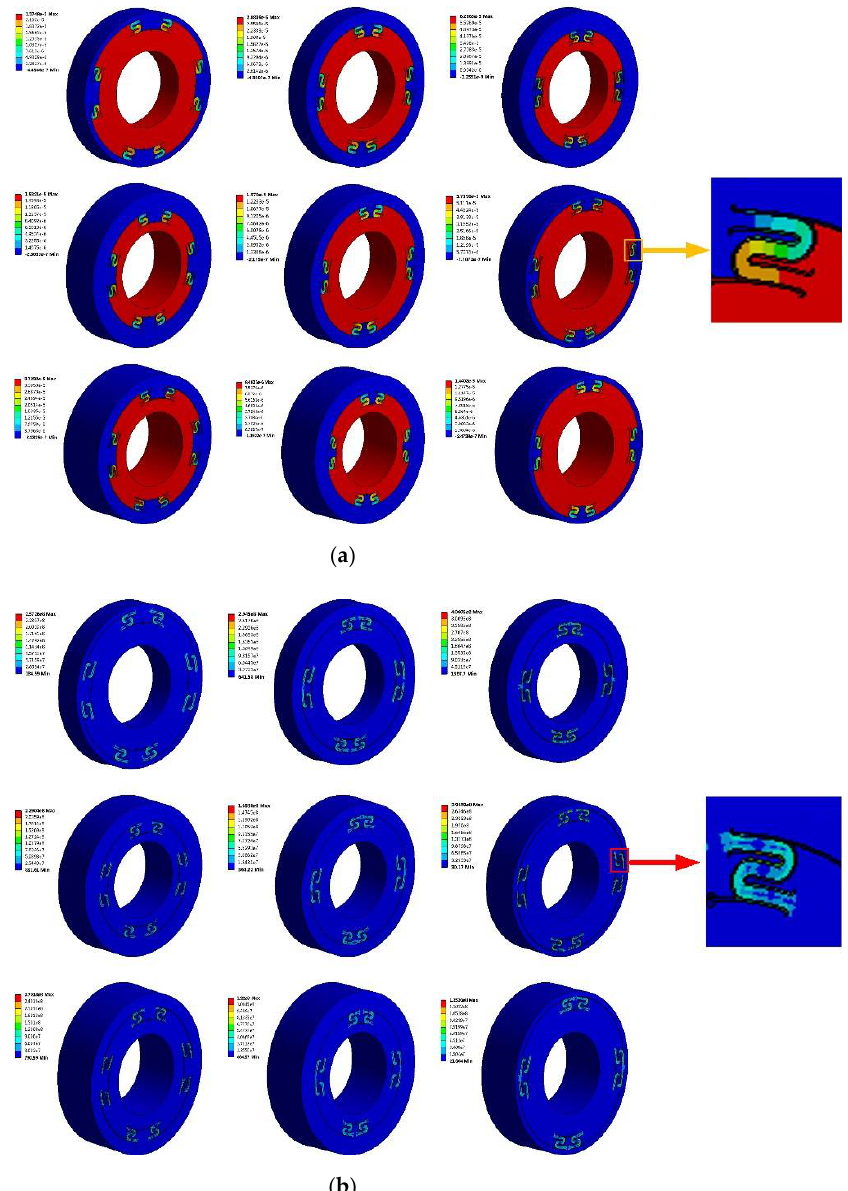
Figure 7. Simulation results of Run No. 1–9 of stiffness and stress: ( a ) Stiffness plot; ( b ) Stress plot. A four-factor, three-level orthogonal test table L 9 (3 4 ) is used to conduct three replicate experiments to increase sample diversity and reduce the effect of error. A total of 27 sets of data are shown in Table 1 and one series of results is presented in Figure 8. The ANOVA weight analysis method is used to determine the importance of structural parameters on performance characteristics. Moreover, the mean analysis of the main effects is performed using graphical plots, which is useful for understanding the trends of the input parameters on the response